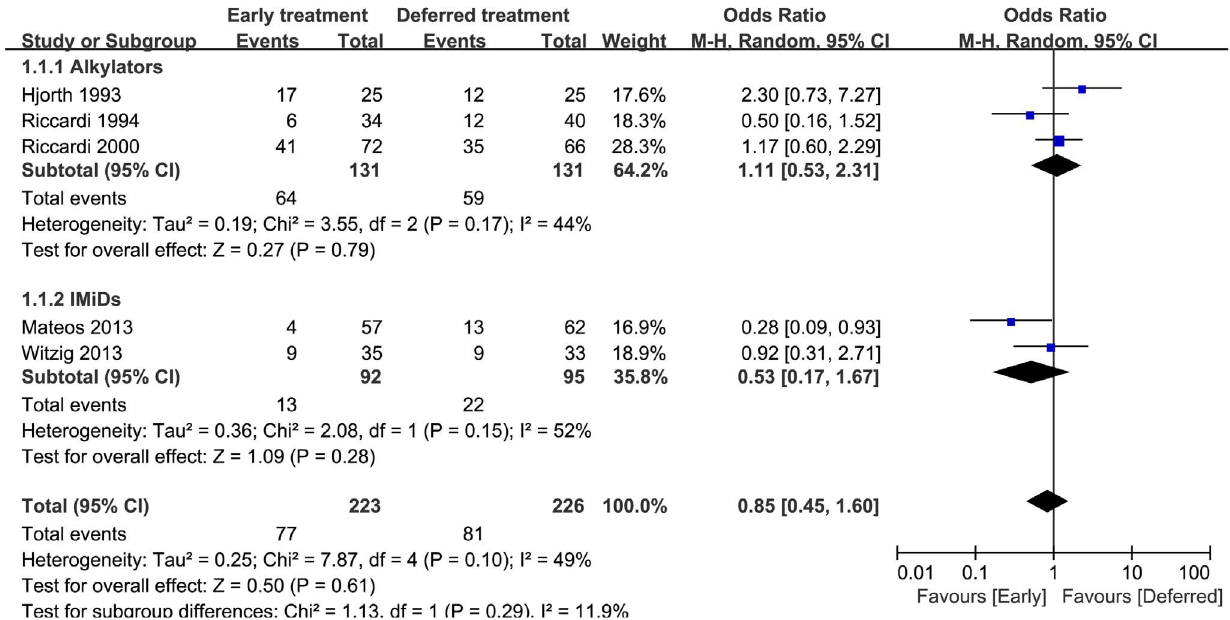
Figure 2. Mortality odds ratios of early treatment versus deferred treatment. The 95% CIs are shown. Squares represent the odds ratios and 95% CI for alkylators or IMiDs and finally for the overall estimate. CIs, confidence intervals; IMiDs, immuno-modulatory